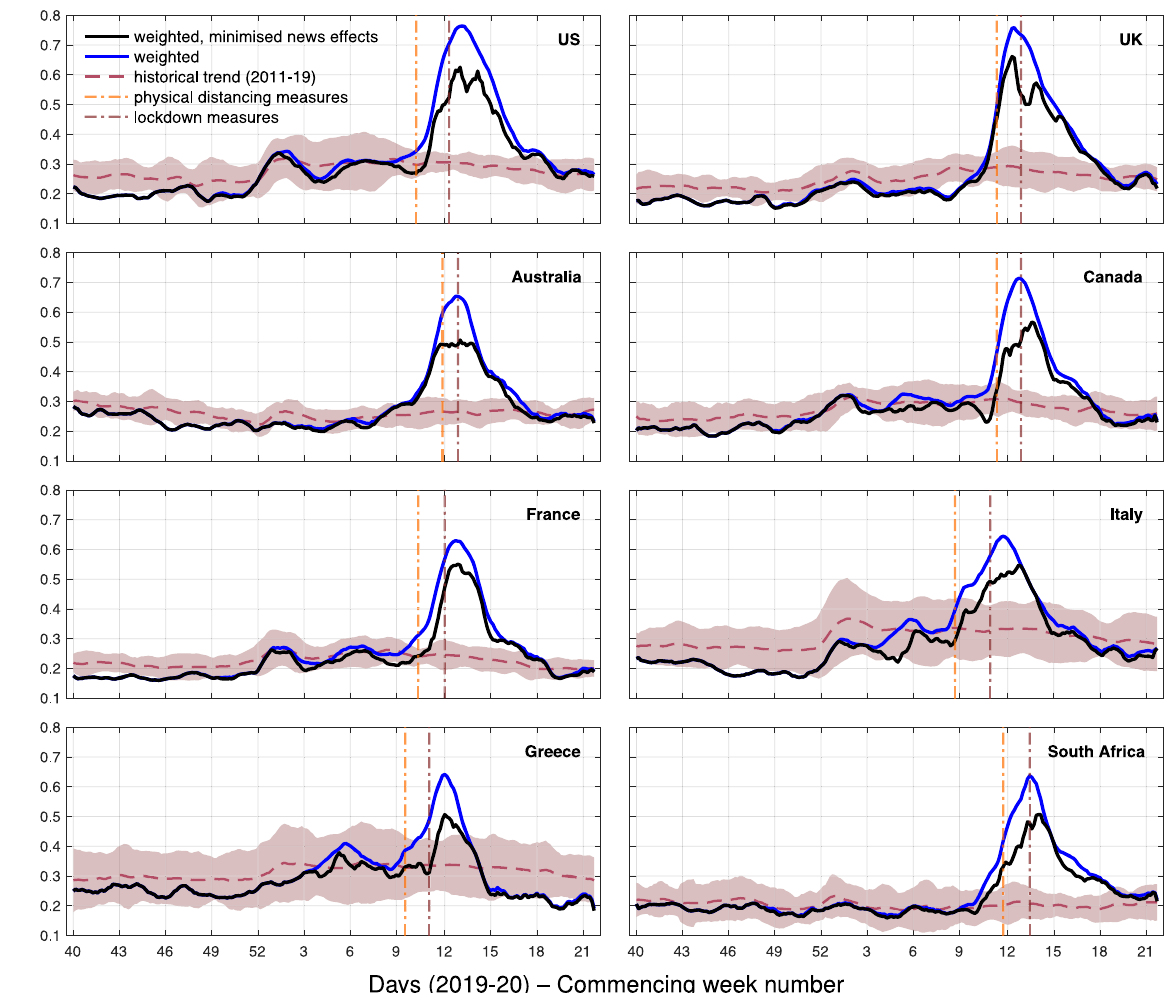
Fig. 1 Online search scores for COVID-19-related symptoms as identi fi ed by the FF100 survey, in addition to queries with coronavirus- related terms, for 8 countries from September 30, 2019 to May 24, 2020 (all inclusive). Query frequencies are weighted by symptom occurrence probability (blue line) and have news media effects minimised (black line). These scores are compared to an average 8-year trend of the weighted model (dashed line) and its corresponding 95% con fi dence intervals (shaded area). Application dates for physical distancing or lockdown measures are indicated with dash-dotted vertical lines; for countries that deployed different regional approaches, the fi rst application of such measures is depicted. All time series are smoothed using a 7-point moving average, centred around each